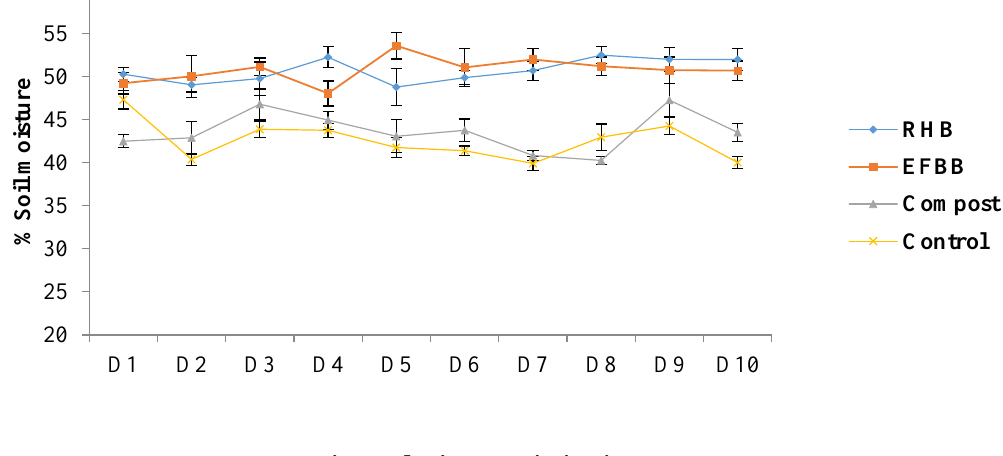
Figure 3. Effect of organic amendments (RHB, EFBB, compost and control) on percentage of soil moisture content at different drying cycles of alternate wetting and drying irrigation. Vertical bars in the graph indicate the standard error of means ( ± SE, n = 4). RHB, AWD: alternate wetting and drying; RHB: rice husk biochar; EFBB: oil palm empty fruit bunch biochar; control: no organic amendment.